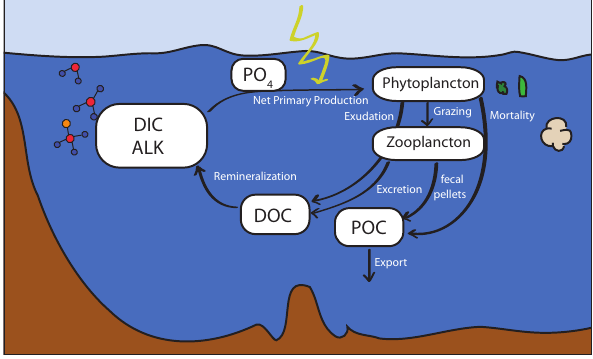
Figure 1. Schematic of the ocean carbon cycle in i LOVECLIM.